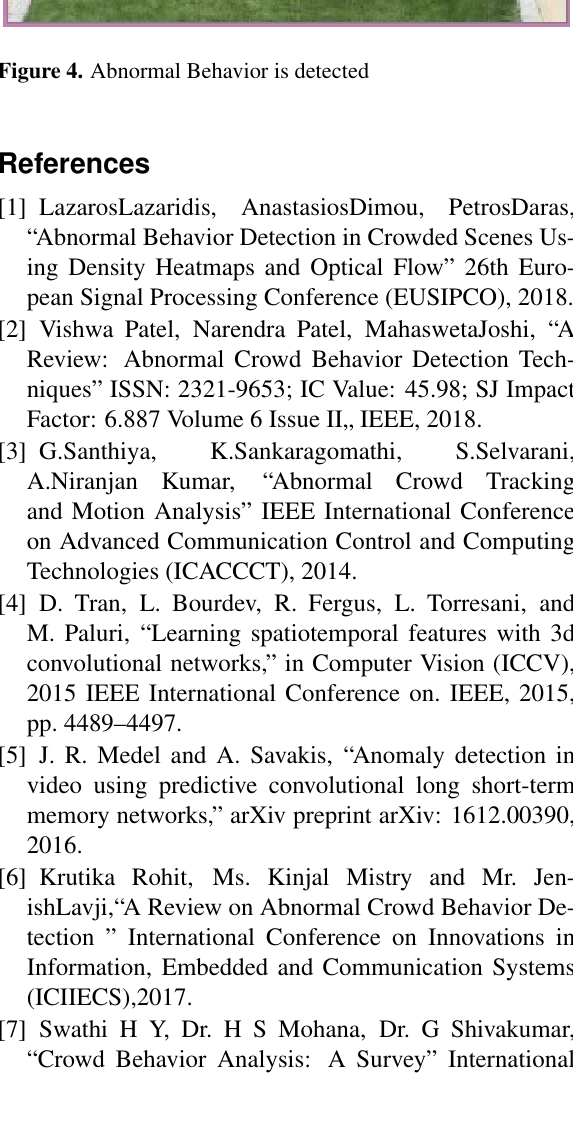
Table 1. CONFUSION MATRIX OF THE EXISTING